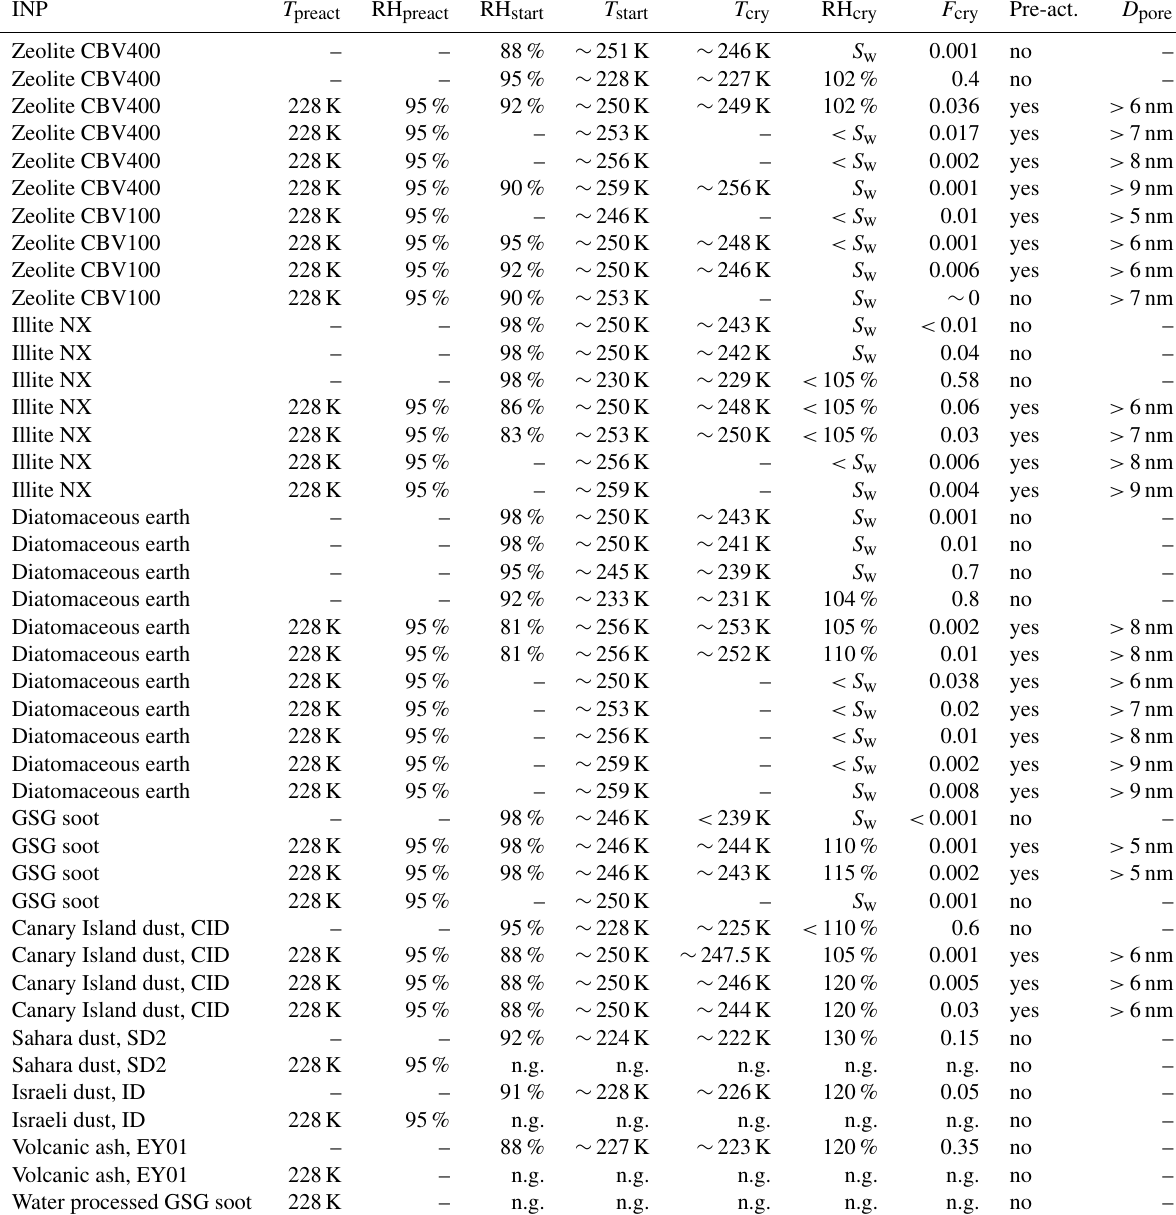
Table 11. AIDA chamber experiments by Wagner et al. (2016). T preact – pre-activation temperature; RH preact – pre-activation RH with respect to ice; RH start – RH with respect to ice at the start of the expansion run; T start – starting temperature of the expansion run; T cry – crystallization temperature; RH cry – crystallization RH with respect to ice; F cry – crystallized particle fraction; D pore – pore diameter needed to prevent ice from melting; S w – water